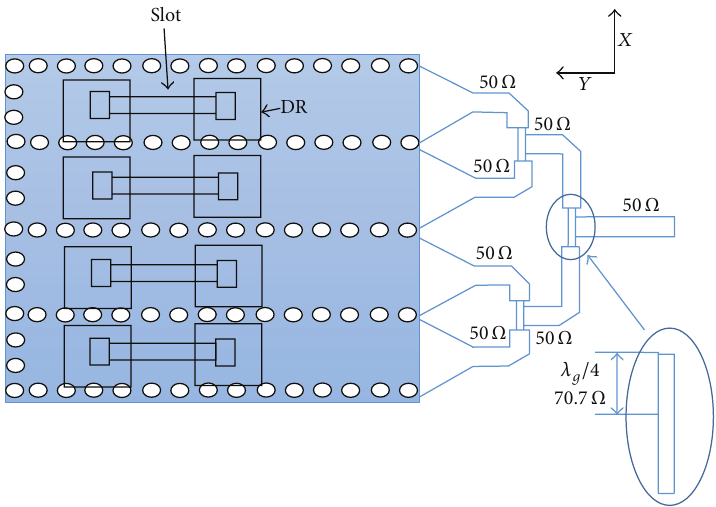
Figure 7: 2-D top view: SIW 1 × 4 antenna array with feeding